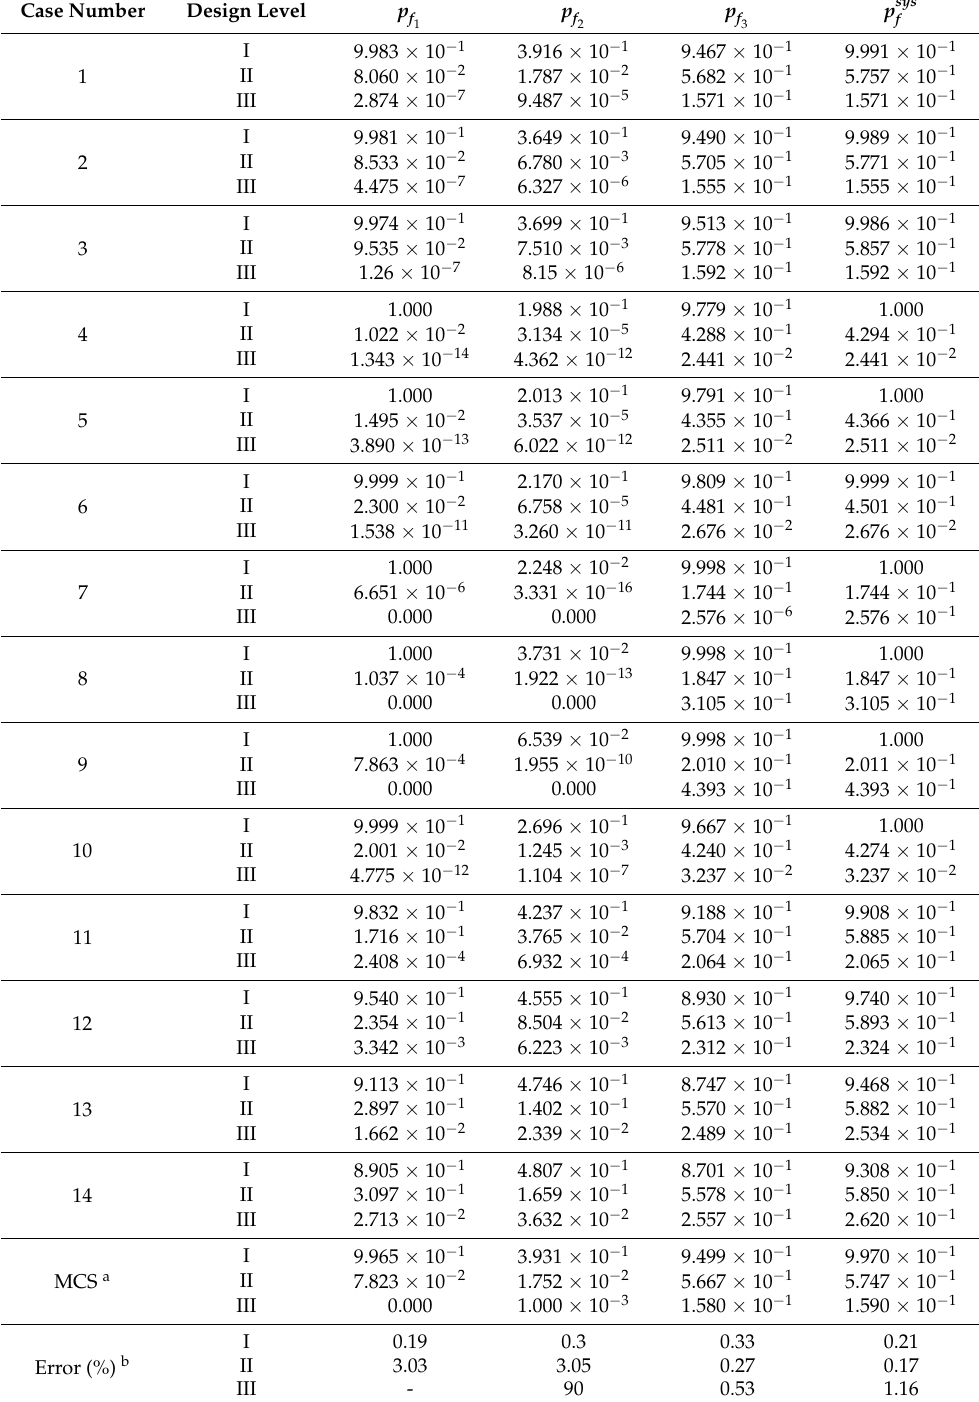
Table 4. Probabilities of failure in different